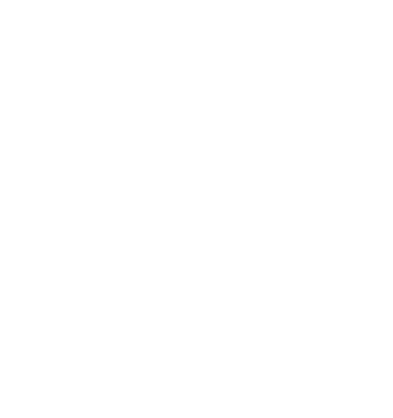
Figure 8. Resistance of each track from 15 to 80 mils (10.381 to 2.032 mm) printed with M5 ink, three layers, and 90 threads/cm mesh.